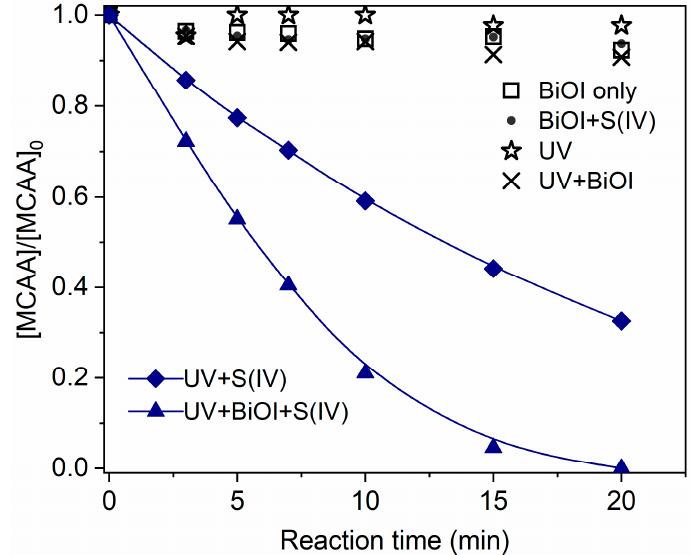
Figure 2. Efficiency of monochloroacetic acid (MCAA) degradation by different processes. Figure 2. E ffi ciency of monochloroacetic acid (MCAA) degradation by di ff erent processes. Conditions: Conditions: [BiOI] 0 = 1.0 g ⋅ L − 1 (84.9 μ M as I); [S(IV)] 0 = 1.0 mM; [MCAA] 0 = 10 μ M; [DO] 0 = 0.22 mM [BiOI] 0 = 1.0 g · L − 1 (84.9 µ M as I); [S(IV)] 0 = 1.0 mM; [MCAA] 0 = 10 µ M; [DO] 0 = 0.22 mM (7.1mg · L − 1 ); (7.1mg ⋅ L − 1 ); pH = 7.0, 25 ± 1 °C. pH = 7.0, 25 ± 1 ◦